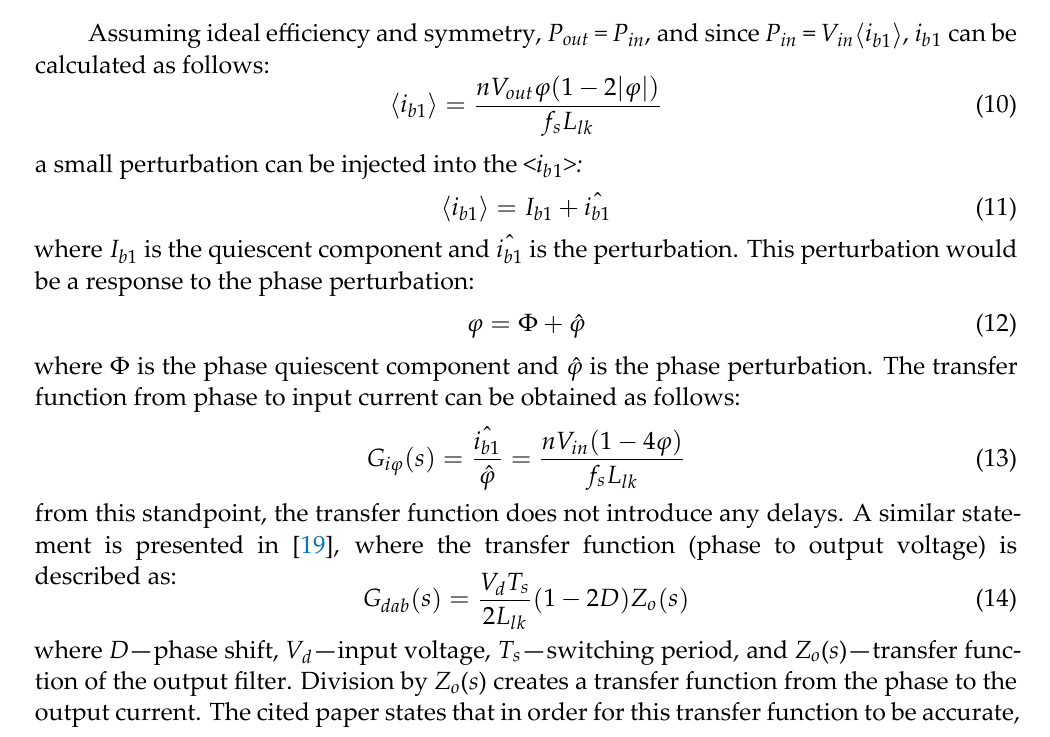
Figure 6. Equivalent circuit of the dual active bridge converter.